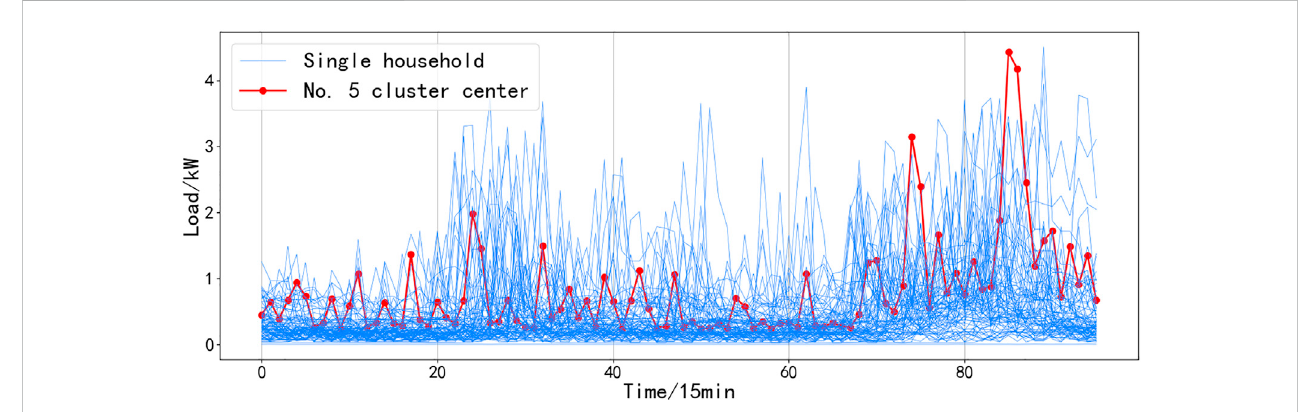
FIGURE 8 Category 1 of residential electricity mode and the clustering center of it.